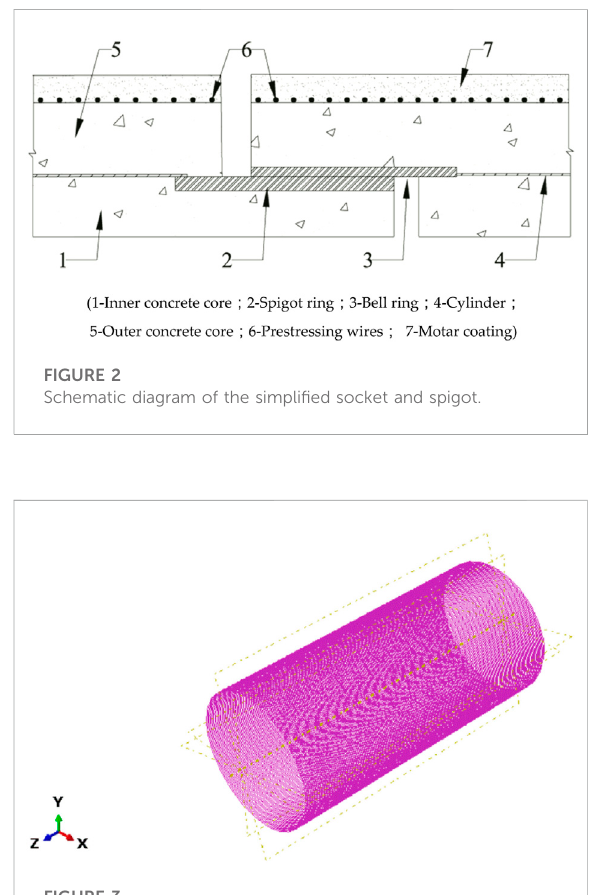
FIGURE 3 Finite-element mesh model of the prestressing wires.